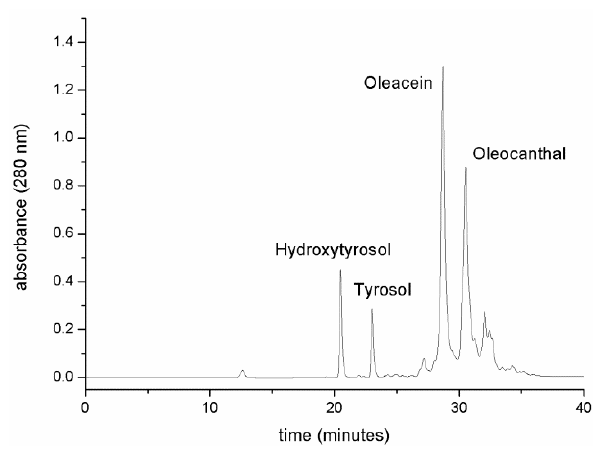
Figure 8. Reverse phase preparative HPLC purification of the compounds from NaDES extracts .